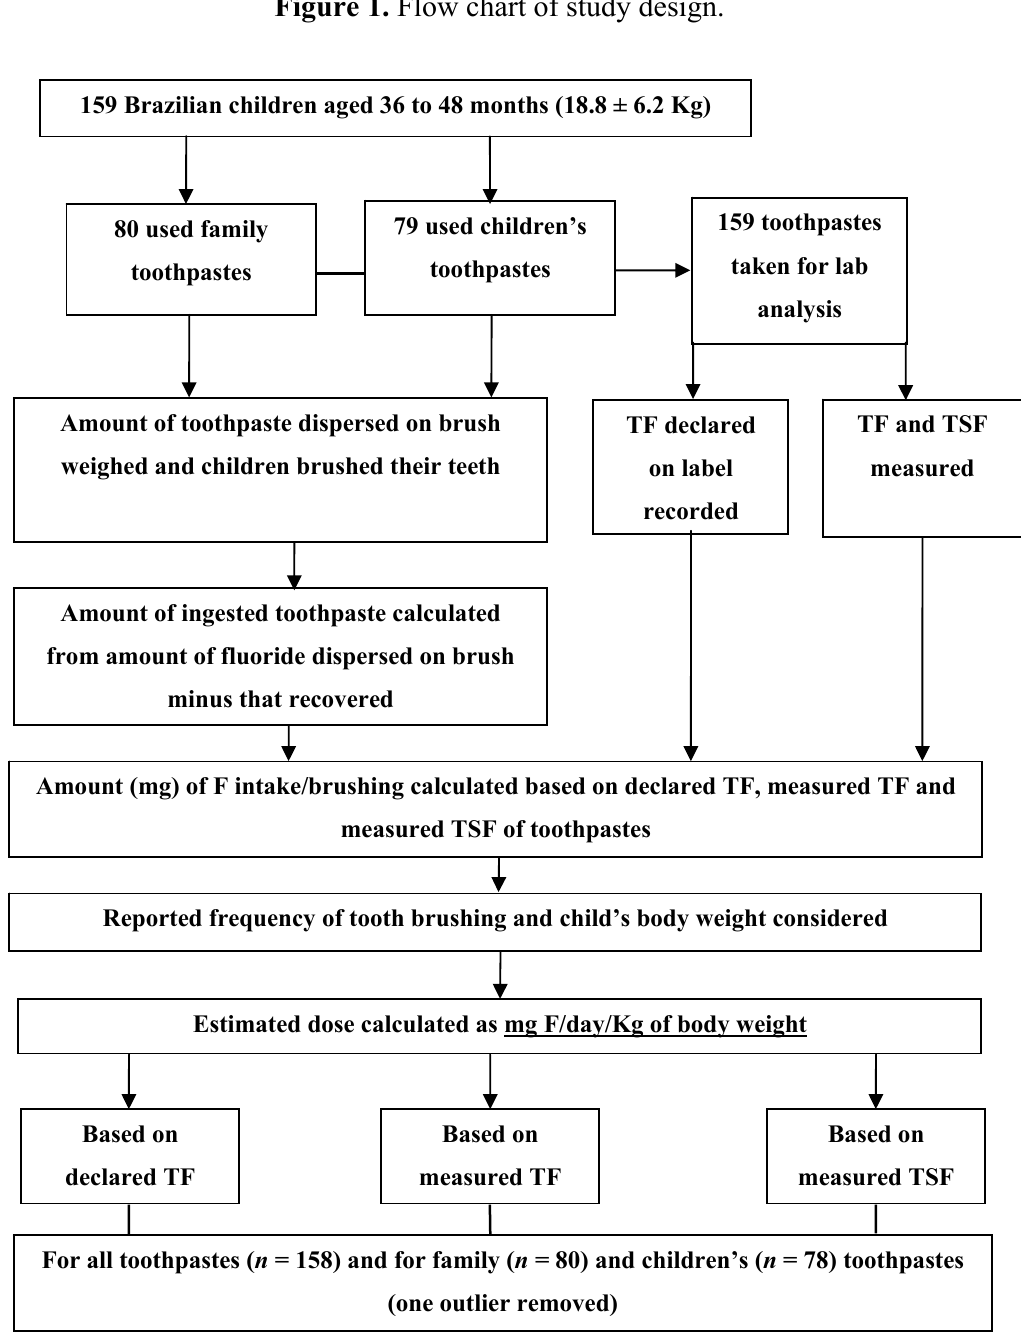
Figure 1. Flow chart of study